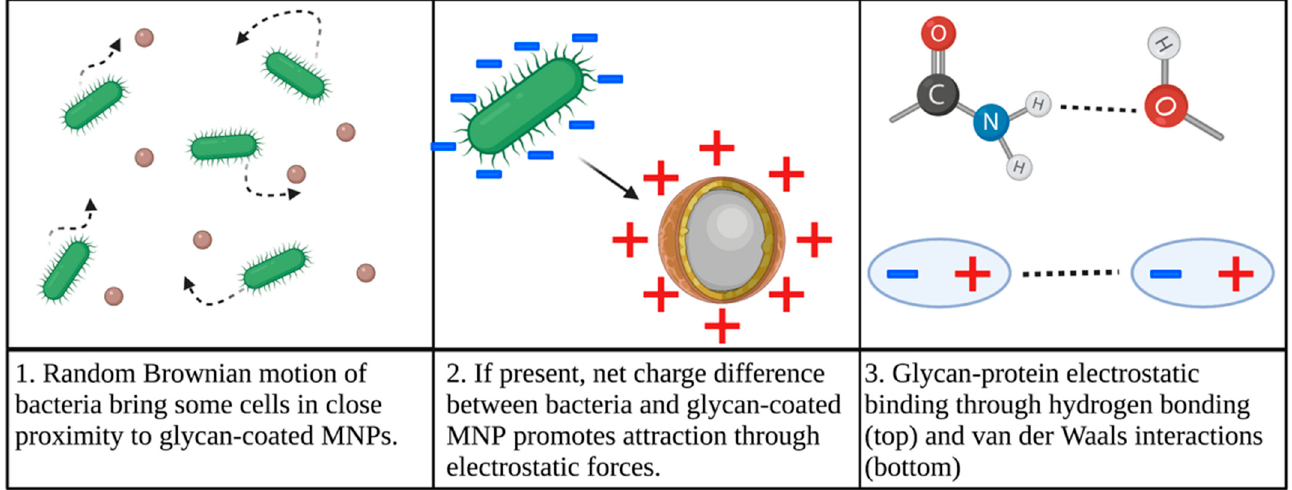
Figure 3. Overview of hypothesized mechanism for glycan-coated MNP binding to